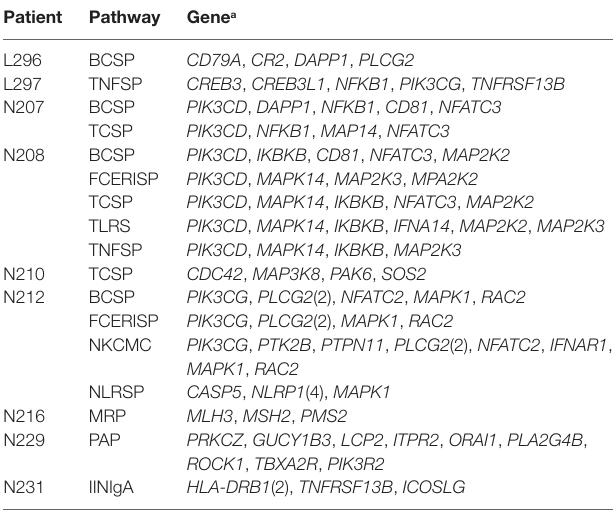
TaBle 7 | Pathways with an excess of genes with rare functional variants in common variable immunodeficiency (CVID) patients.